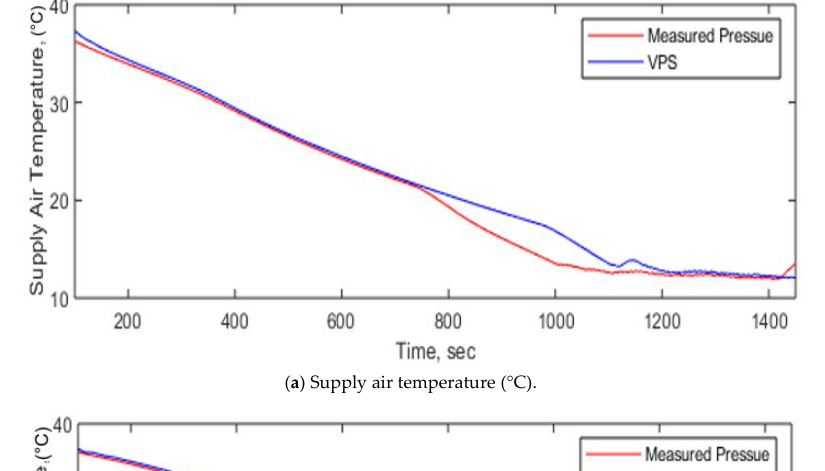
8 of 15 Figure 7. Model in the Loop (MIL) test framework. Three MIL simulation cases are used to evaluate the VSP performance of estimating the pressure/superheat temperature in EXV control:  MIL simulation scenario 1: The refrigerated space temperature was cooled from 37.8 °C to 13.9 °C under 37.8 °C ambient temperature.  MIL simulation scenario 2: The refrigerated space temperature was cooled from 37.8 °C to 1.7 °C under 37.8 °C ambient temperature. 